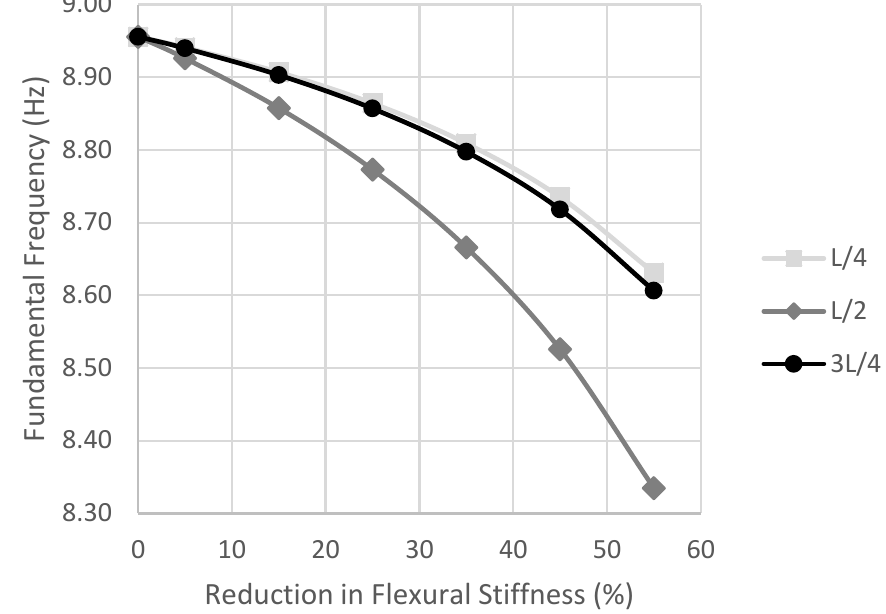
Figure 2. Change in fundamental frequency given different damage levels. To account for speed variability in practice, acceleration time histories were simulated for 100 randomly generated speeds with a mean of 100 kph and covariance of 10%. This resulted in a total number of 21,000 simulated acceleration signals. Figure 3 shows a sample of simulated signals for both bogies under healthy state and different damage scenarios and the vehicle speed of 105 kph. The difference between healthy and damaged signals in the front bogie is 0.06 m/s 2 at the maximum damage level of 55% and is 0.0097 m/s 2 at 5%